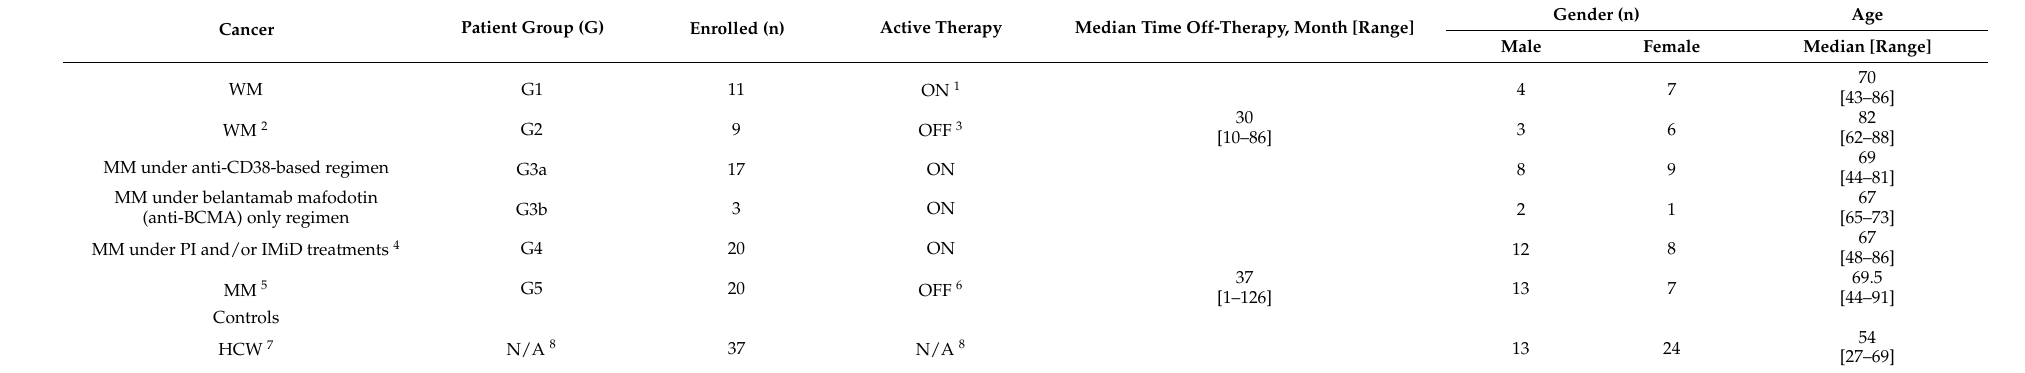
Table 1. Characteristics of Vaccine